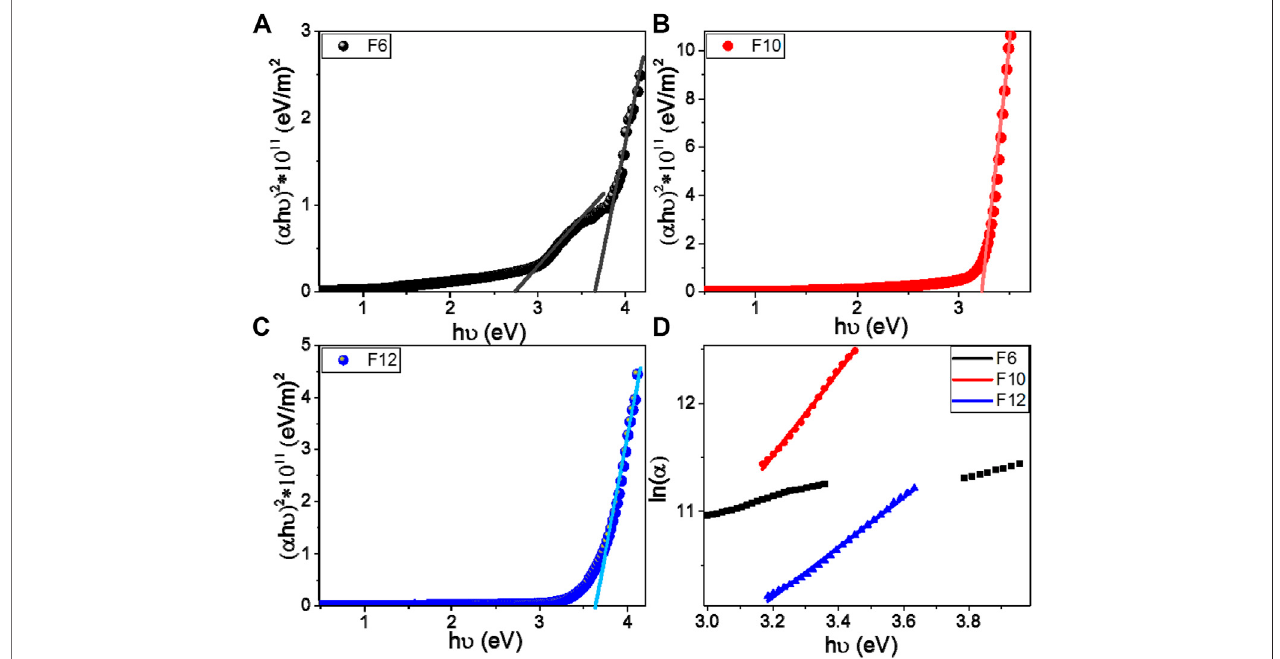
FIGURE 6 | Calculation of energy gap (A – C) and Urbach energy (D) for F 6 , F 10 , and F 12 fi lms.